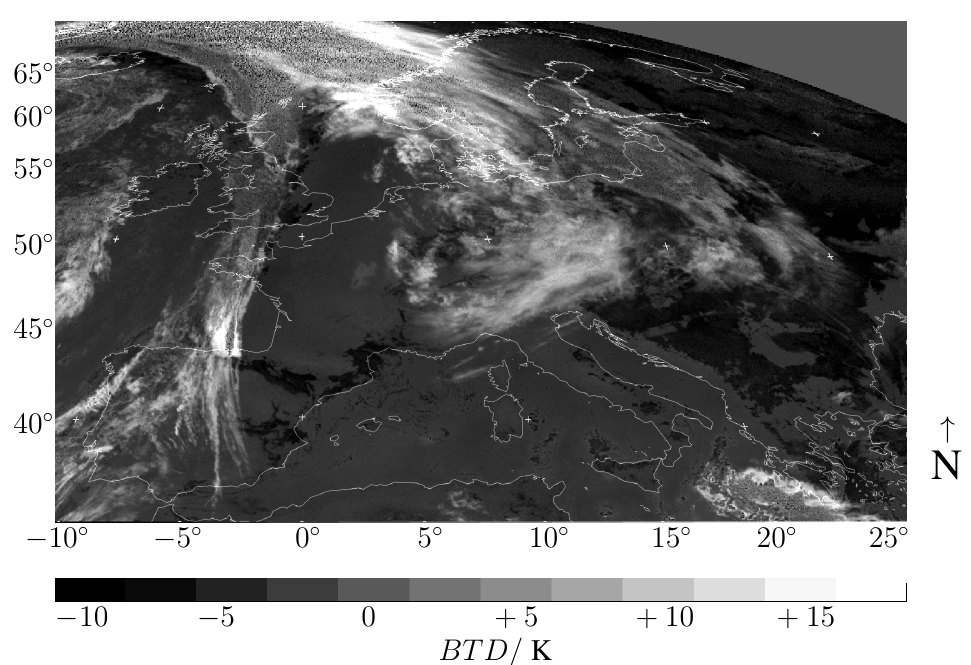
Figure 4. Example of a brightness temperature difference image for Europe, 01 November 2014, 0300 UTC. Dark areas contain fog and low stratus, bright areas other